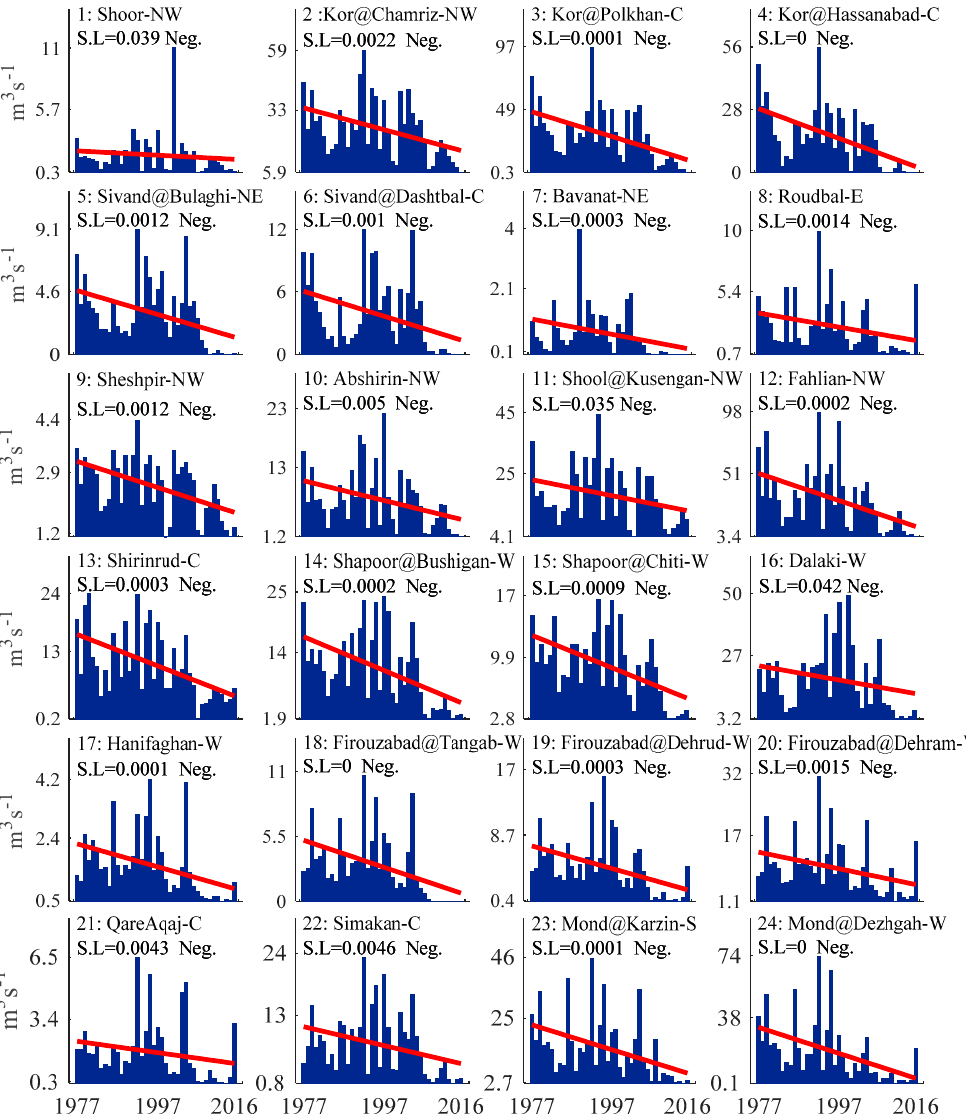
Figure 5. Trend in flow in selected rivers across the study area (1977–2016). The Kor, Firouzabad, and Mond rivers had more than one selected station, so station names are added. Neg. and Pos. are negative and positive trends. Regions: W: western, NW: northwestern, C: central, S: southern, E: eastern, NE: northeastern. SL: significance level. Detailed information on all stations is available in